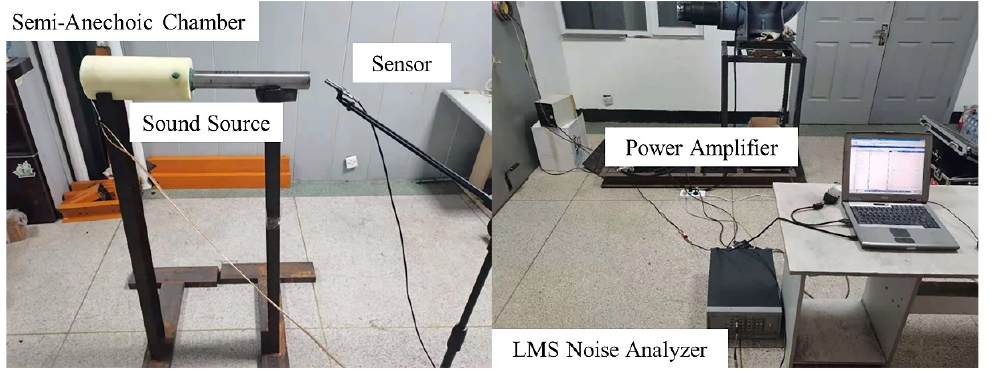
Figure 6. Photograph of experimental setup for insertion loss.